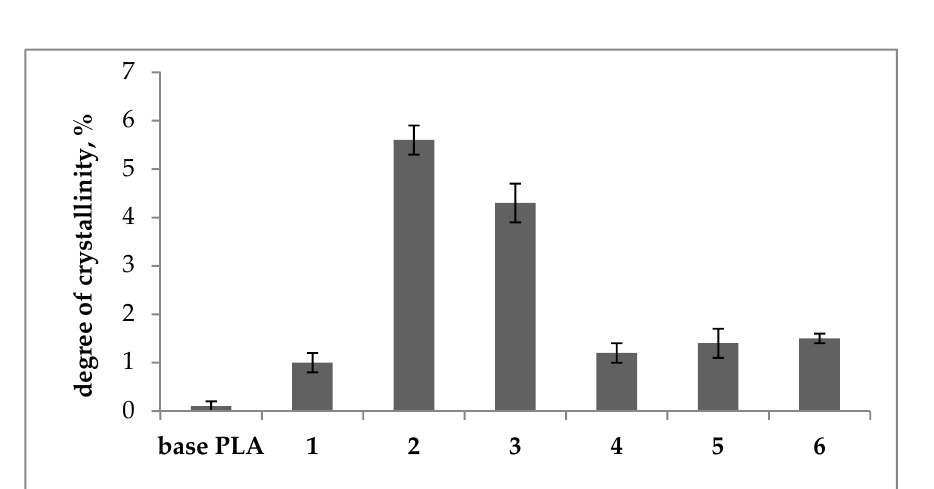
Figure 1. Degree of crystallinity of base and plasticized PLA. Analyzing the results obtained from the thermal tests (Table 2), it can be seen that the glass transition temperature (T g ) for all modified samples was shifted towards lower values compared to the base polymer (Figure 2). For samples 2, 3, 4, and 5, T g values were below 40 ◦ C. The lowest T g value of 34 ◦ C was observed for the regranulate with ethoxylated stearic acid (sample 3). A single glass transition (one T g value) was observed for all modified samples, which proves the good miscibility of the components of the prepared compositions. The plasticizers used in samples 1, 2, and 3 did not cause significant changes in the melting temperature (T m ), while for tests 4, 5, and 6, a double transition to the plastic state was observed, as evidenced by two T m values (Tabele 2). In the tested samples, however, there were differences in the cold crystallization temperature (T cc ) and the cold crystallization enthalpy ( ∆ cc ), which indicates the low-ordered structure. A slight increase in the degree of crystallinity of the modified samples was observed in relation to the completely amorphous starting sample (Figure 1). The degree of the structure order is also reflected by the value of the crystallization enthalpy ( ∆ H c ). The applied plasticizers cause a slight increase in the order of the regranulate structure, which is particularly noticeable for samples 2 and